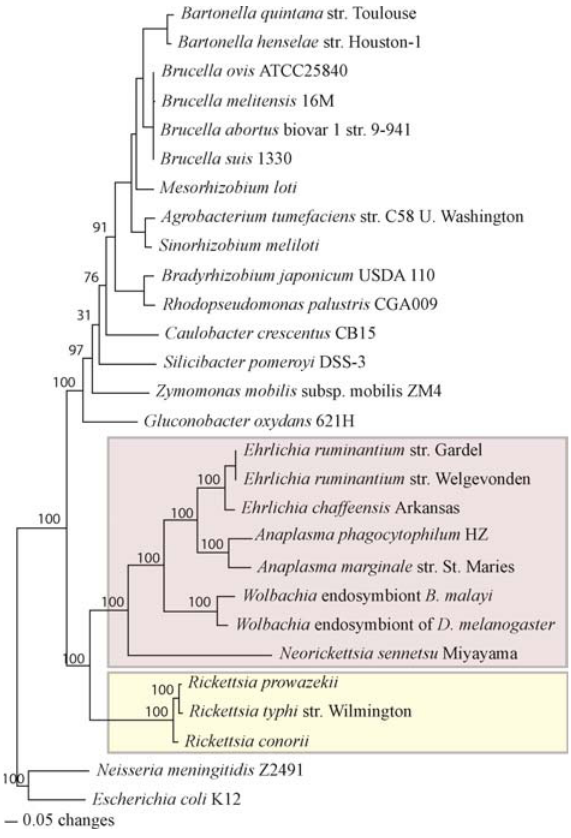
Figure 1. Phylogenetic Tree of the a -Proteobacteria The protein sequences of select conserved genes were concatenated and aligned, and a phylogenetic tree was inferred of all sequenced a - Proteobacteria (see Materials and Methods). The Anaplasmataceae (purple) and the Rickettsiaceae (yellow) are highlighted. DOI: